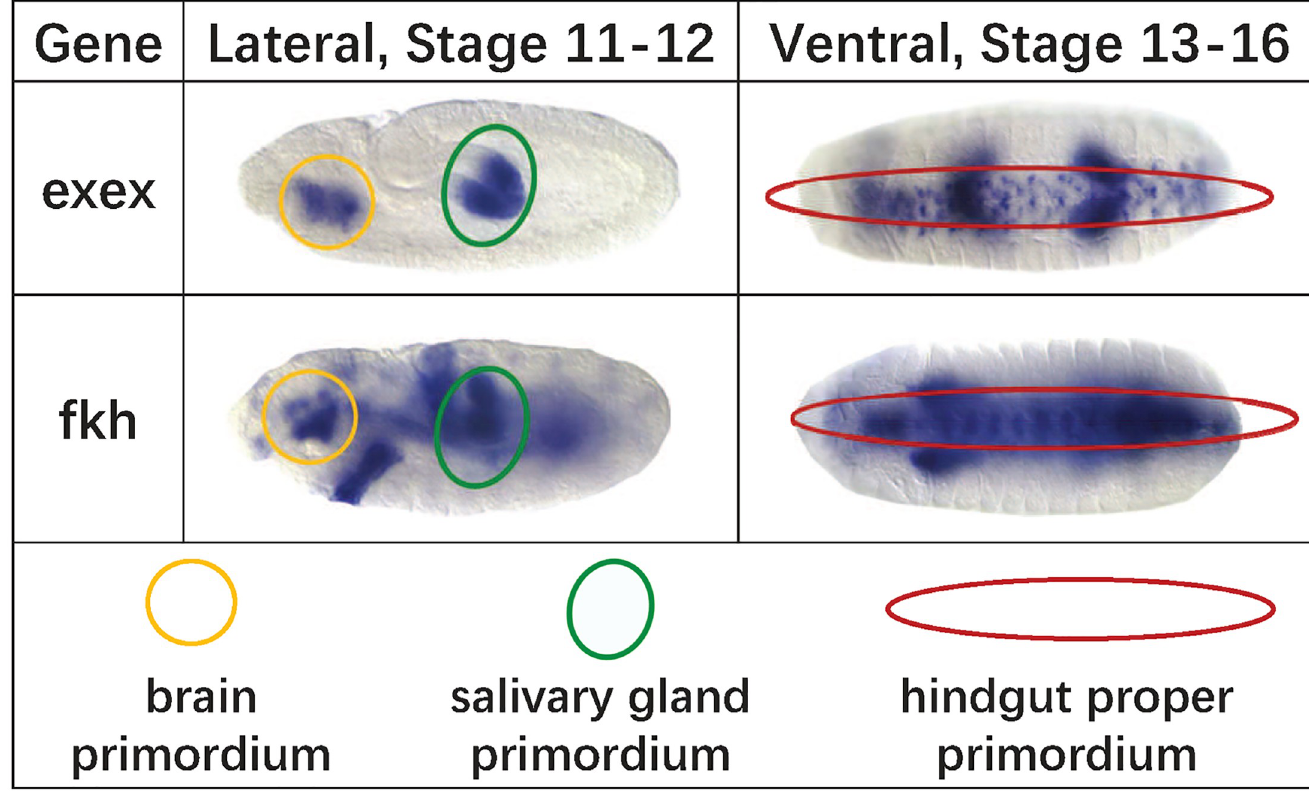
Fig 1. Examples of gene expression images. Two genes, exex and fkh , and their ISH images of lateral and ventral directions. Although the two genes are not similar from the global view, they have three annotation terms in common, i.e. brain primordium, salivary gland primordium and hindgut proper promordium, whose corresponding expression regions are marked by yellow, green, and red circles, respectively.